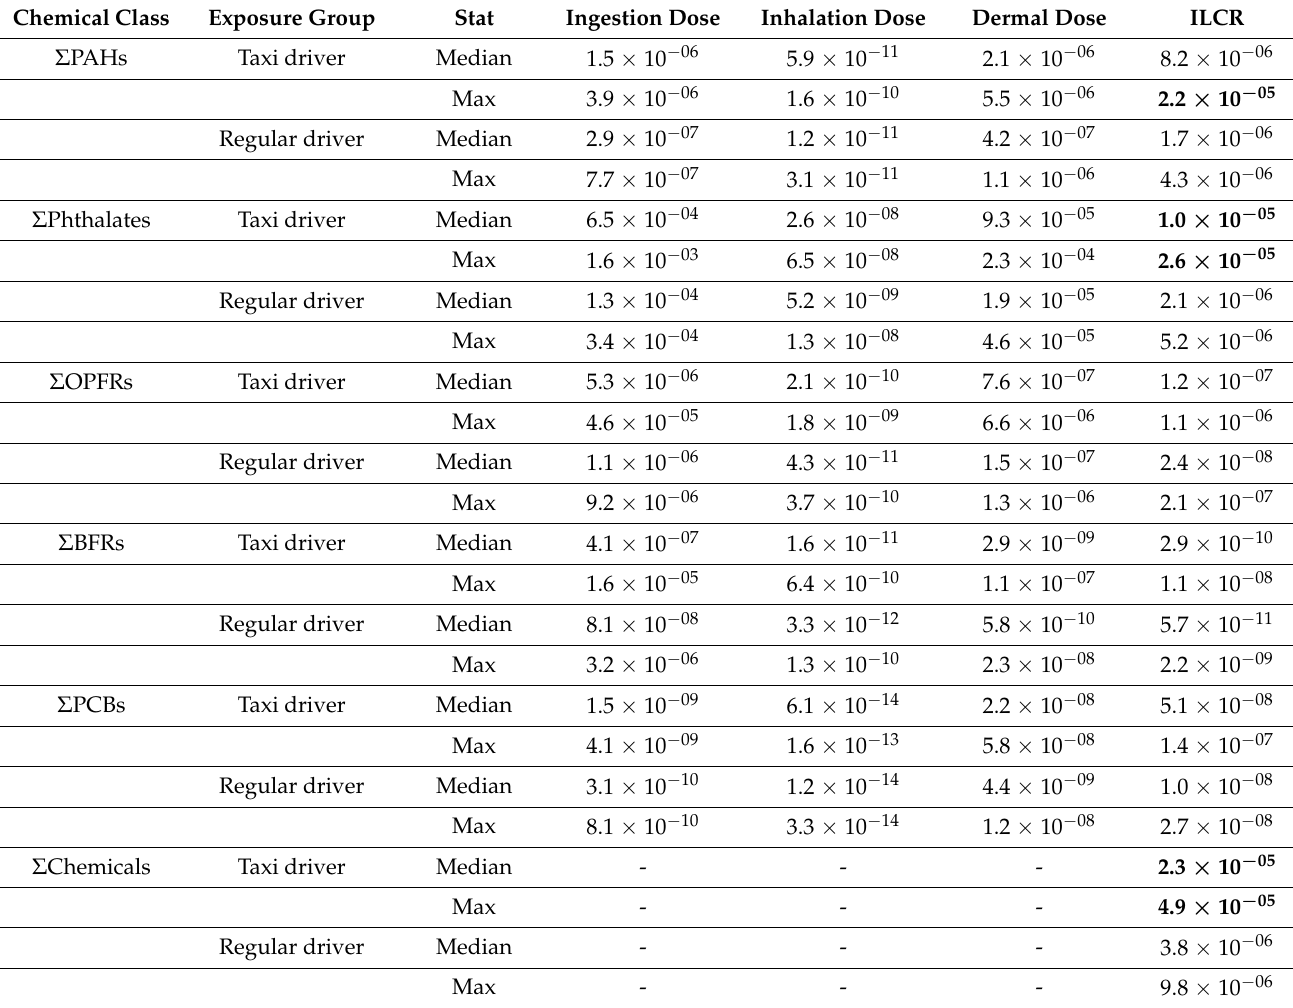
Table 3. The potential cancer risk assessment for taxi and regular drivers via dust exposure. Bold values are considered as cause of